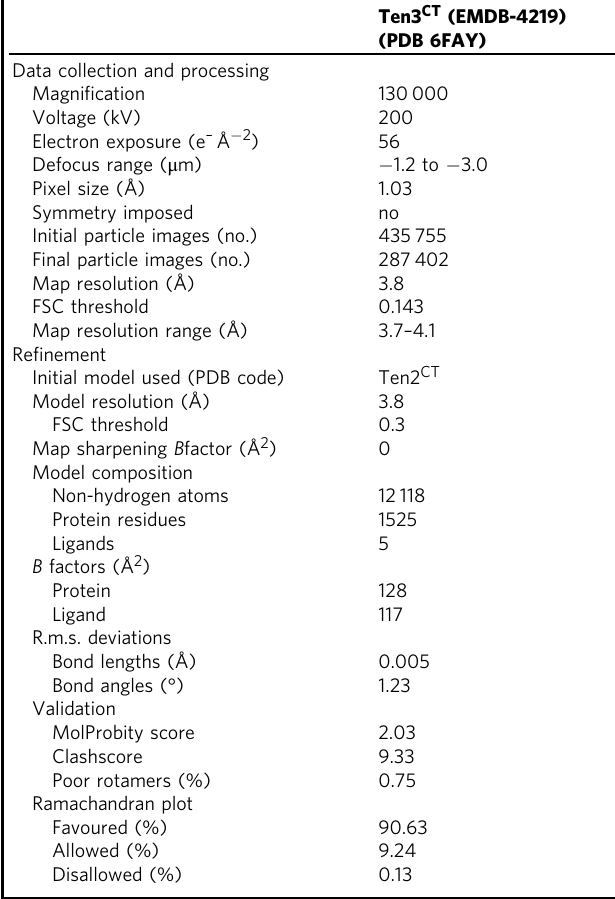
Table 1 Data collection and re fi nement statistics for Ten2 CT data sets